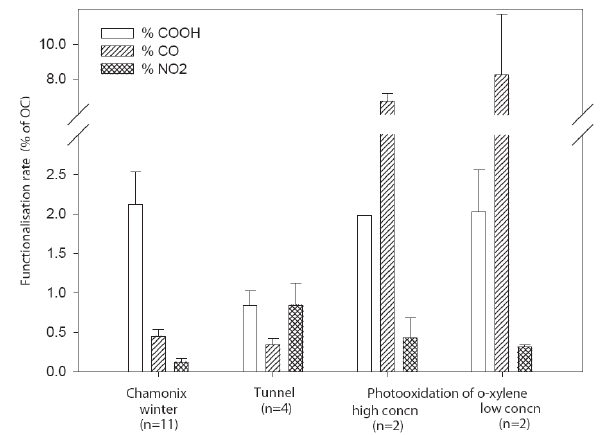
Fig. 1. Functionalisation rates measured in the different aerosols under study. Concentrations are given in terms of functional group Figure 1. Functionalisation rates measured in the different aerosols under study. molar content normalised to the OC molar content (expressed in % Concentrations are given in terms of functional group molar content normalised to the OC of OC). Error bars represent the standard deviations calculated for molar content (expressed in % of OC). Error bars represent the standard deviations calculated each sample for each sample series.